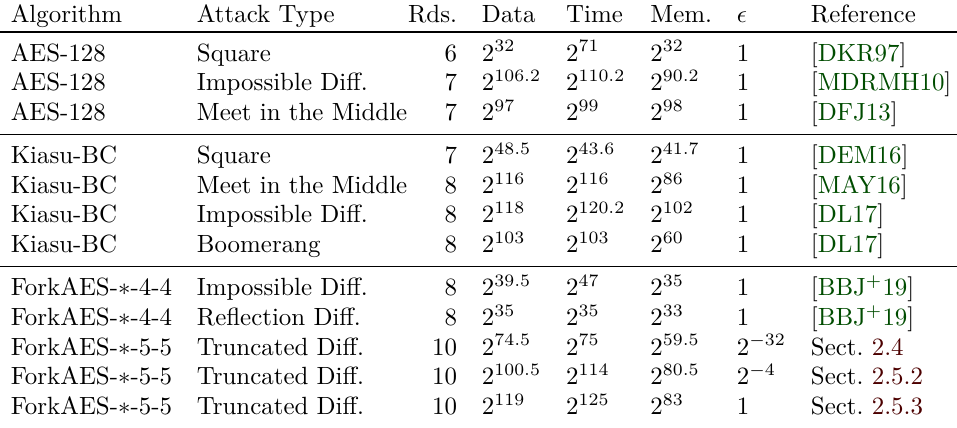
Table 1: Cryptanalysis results against AES, Kiasu-BC, and ForkAES (excluding optimized brute-force). The Time column corresponds to the expected time, and (cid:15) to the fraction of weak keys targeted by the attack.